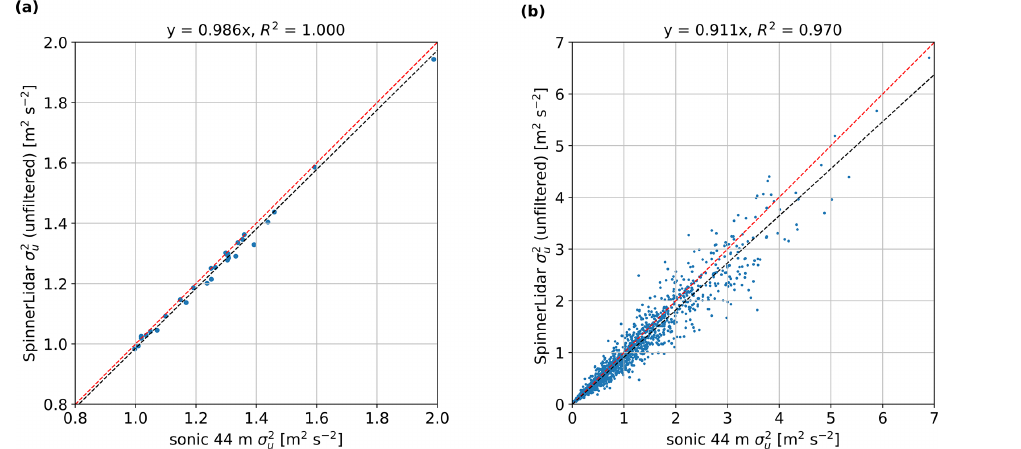
Figure 13. Comparison of the unfiltered variance of the along-wind velocity component between the SpinnerLidar and the sonic anemometer at 44m from (a) numerical simulation using 30 turbulence boxes and (b) measurement